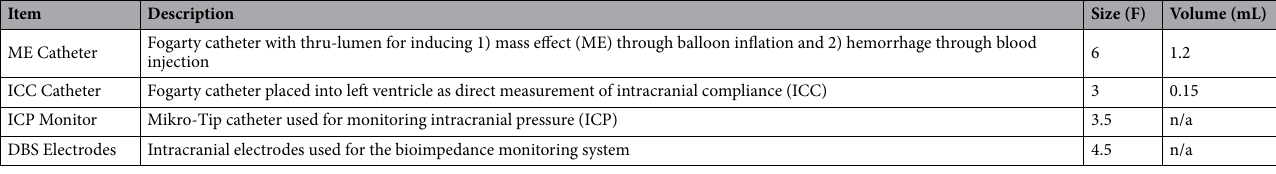
Table 1. Specifications for intracranial